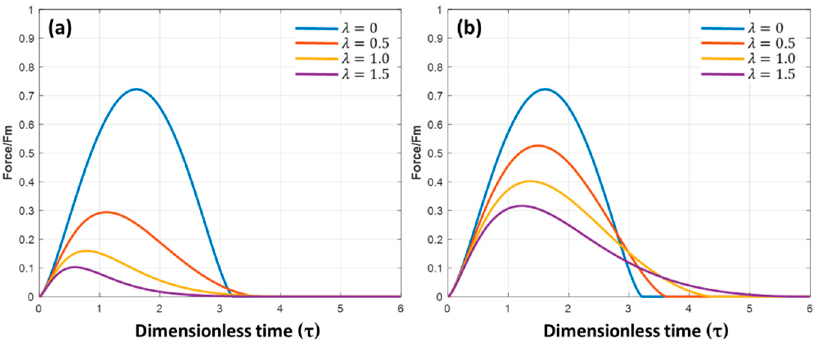
Equation (30) multiplied by e − 0.4 λτ and Figure 4a, Zener’s standard force–time collision curve is the closest.